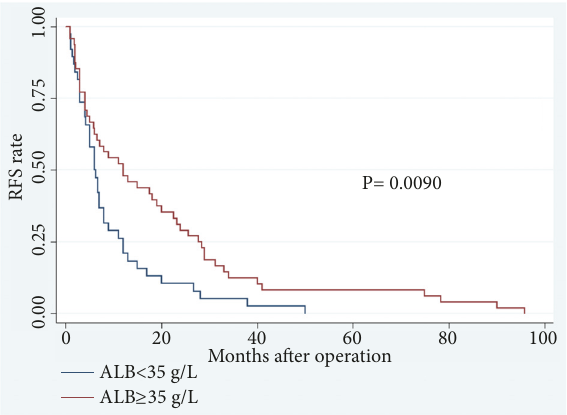
Figure 3: Overall survival in patients with cholangiocarcinoma according to ALB levels (P=0.0290) (ALB, albumin; OS, overall survival).